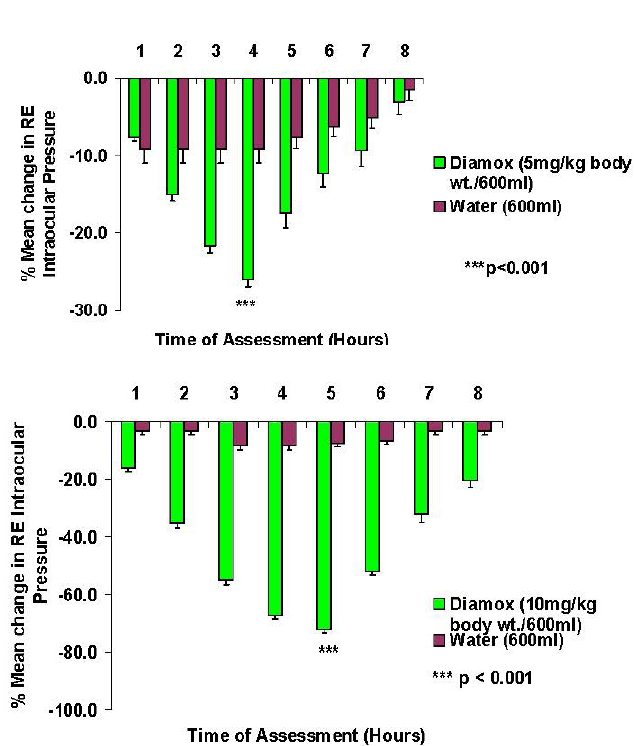
Figure 4 : The peak of fall in percentage mean IOP for 5 mg/kg of acetazolamide was after four hours but the peak of fall for 10 mg/kg of acetazolamide was after five hours of administration.